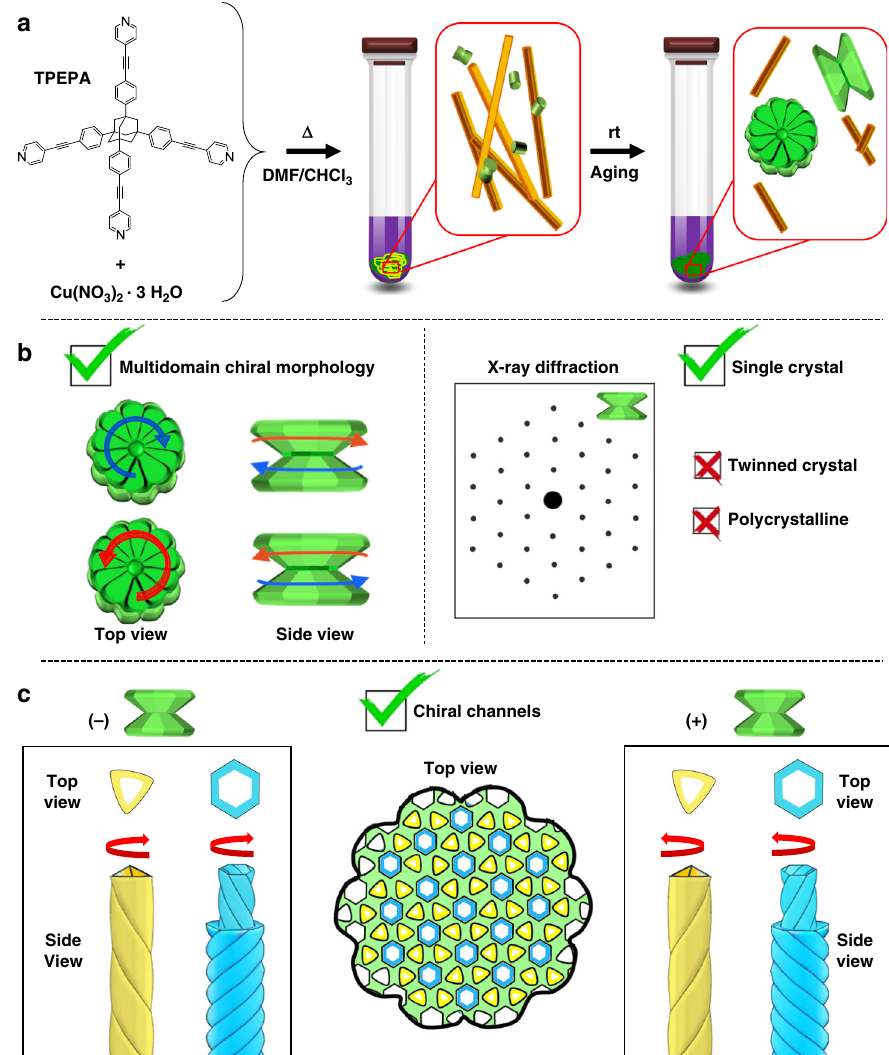
Fig. 1 Single crystals with multidomain morphology, from achirality to multiple chirality. a solvothermal reaction of the achiral organic ligand (TPEPA) with copper(II) nitrate, followed by aging of the sample at room temperature. ( b , left) The single crystals display chiral features at morphological levels: an off-set angle between the constituting disks and a spiral growth phase. ( b , right) X-ray diffraction studies reveal the single crystallinity of the entire, morphological complex structure. c The crystal structure consists of continuous helicoidal channels. Each crystal is enantiopure whereas the bulk sample is